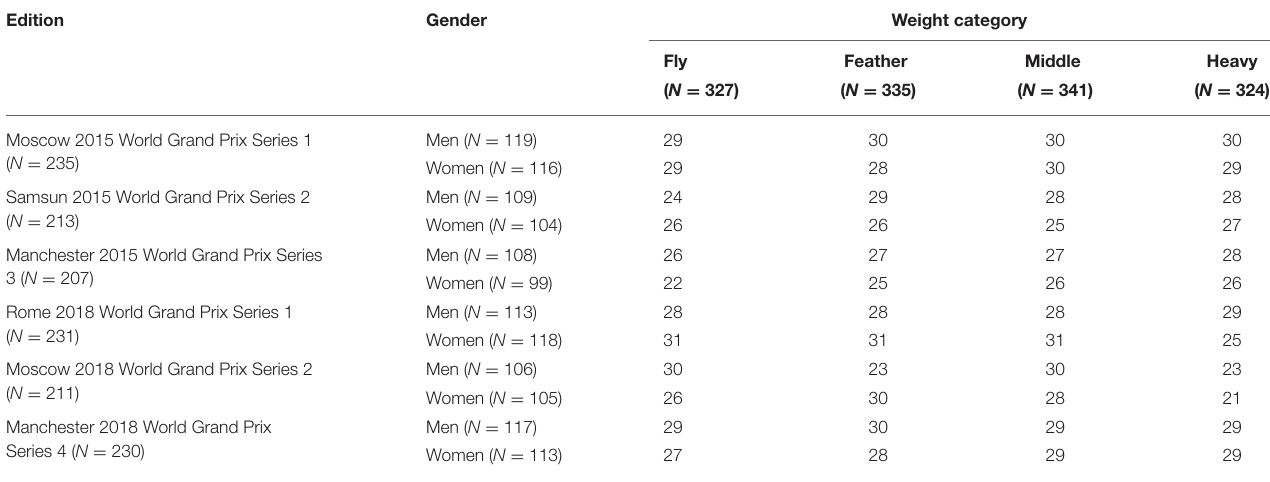
TABLE 1 | Number of matches in each World Grand Prix Series (WGPS)